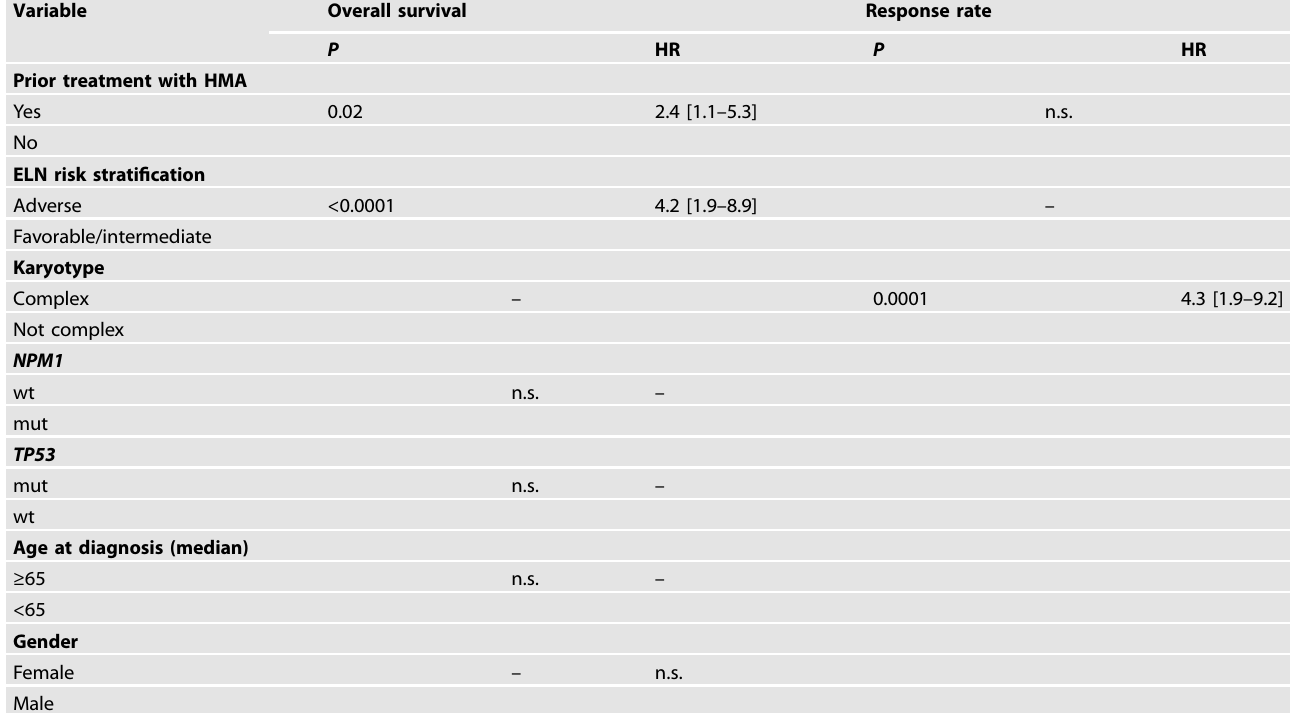
Table 3. Outcome after induction with CPX-351, multivariate analysis.